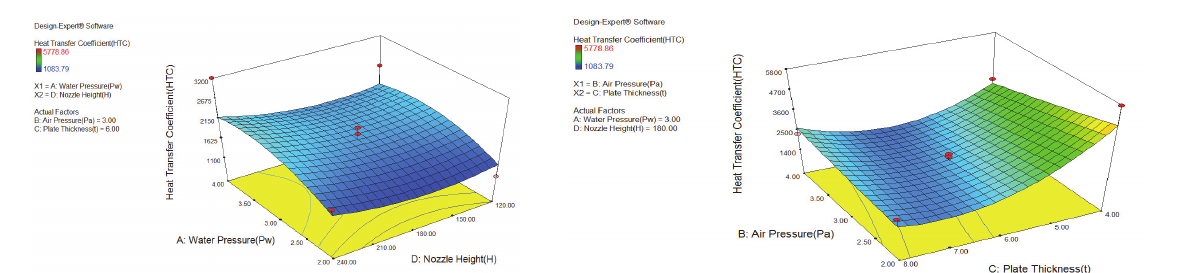
Fig. 4. Variation of HTC with respect to water pressure and nozzle height